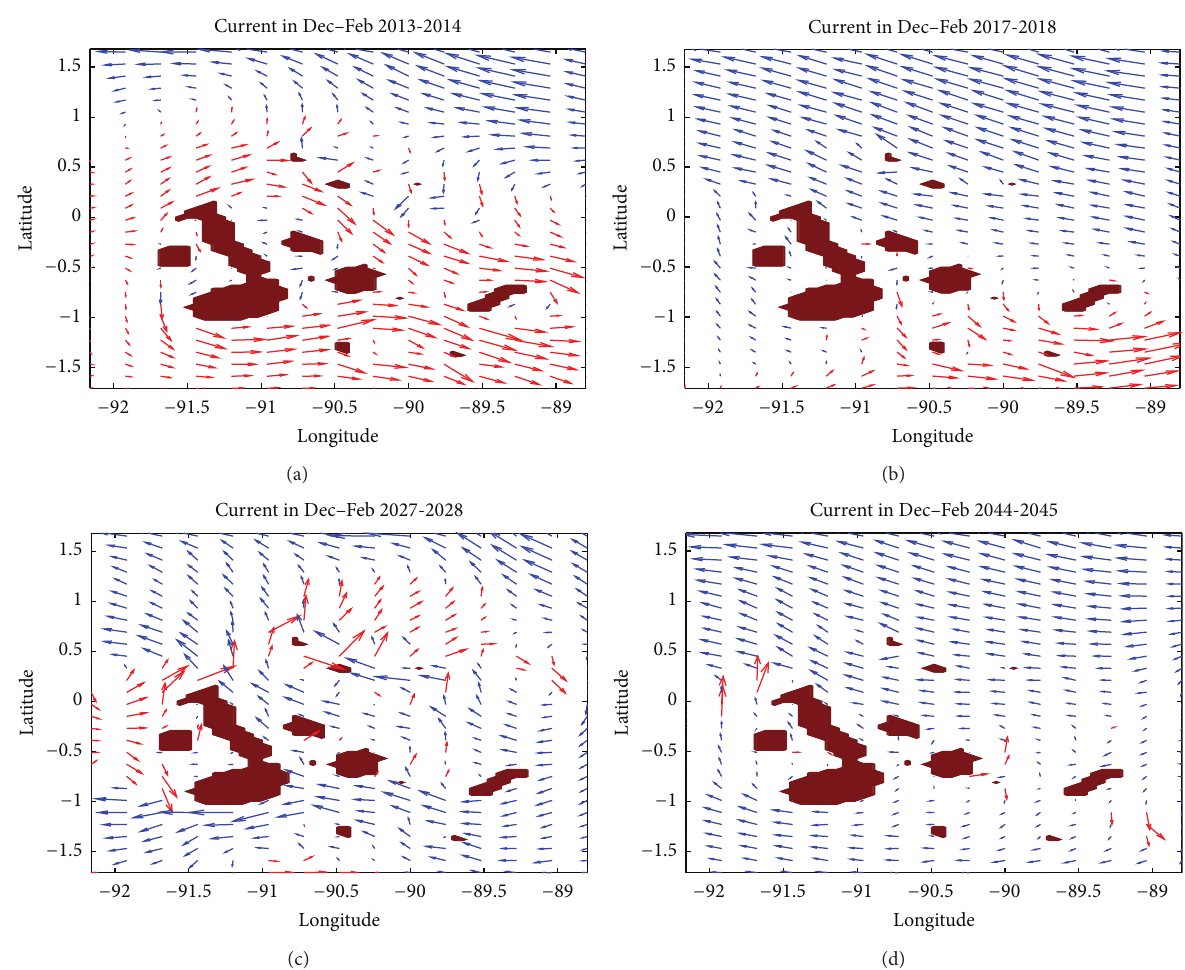
Figure 11: The surface current around the GMR during the El Ni˜no cases: (a) in Dec–Feb in 2013-2014, (b) in Dec–Feb in 2017-2018, (c) in Dec–Feb in 2027-2028, and (d) in Dec–Feb in